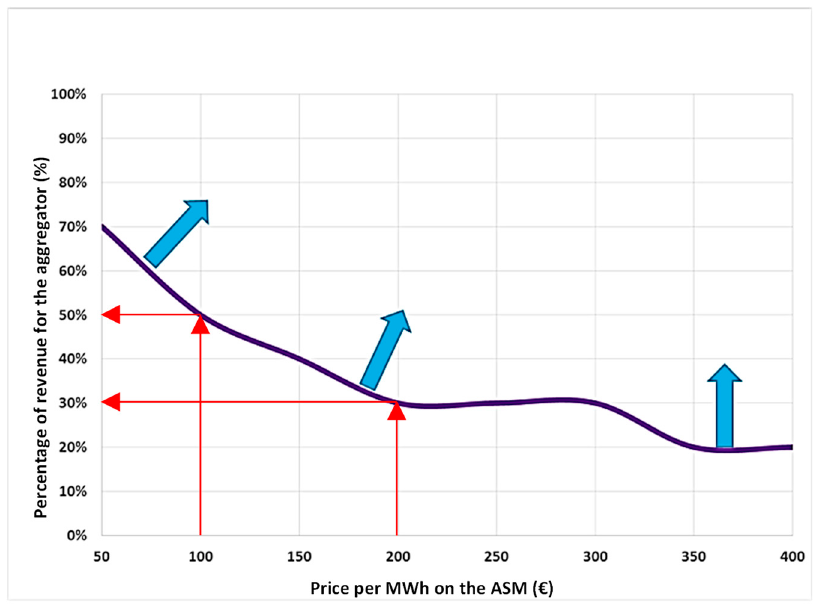
Figure 7. Profit curve for the aggregator, for a predetermined value of energy, exchanged and for a precise combination of the costs of the EMP and COM .